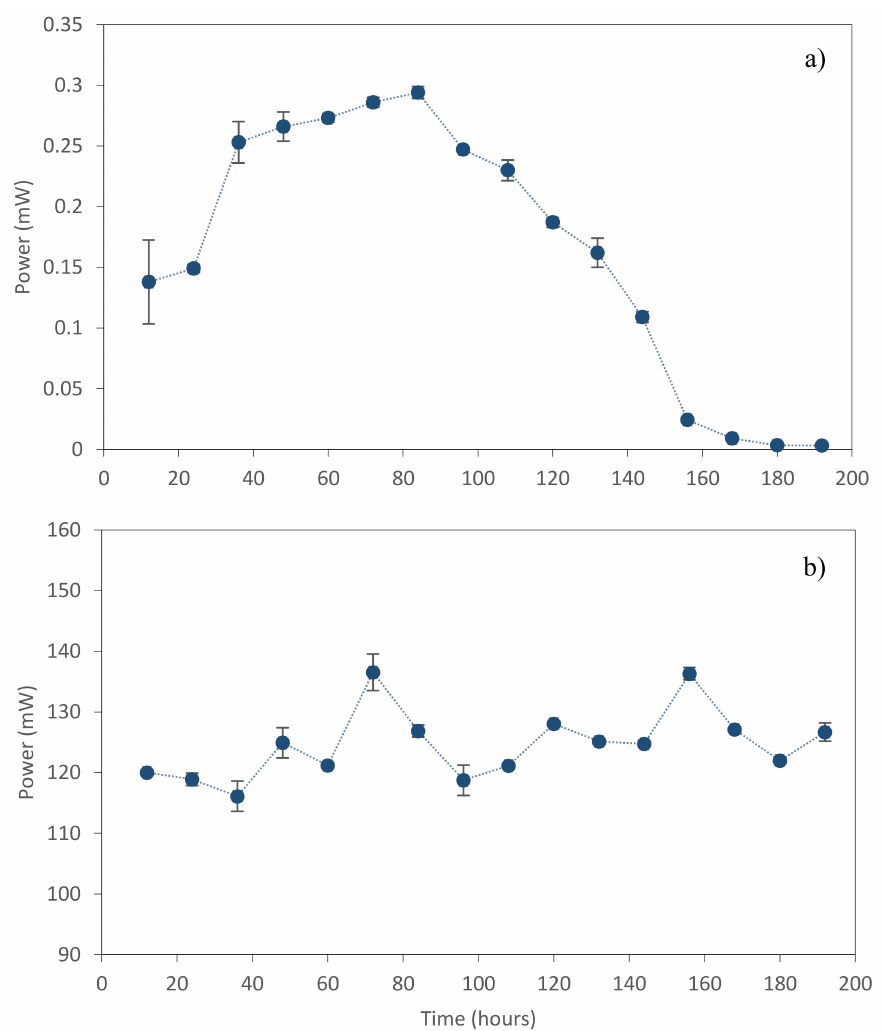
Figure 4. Power over time obtained from ( a ) stacked MFCs connected in parallel with each other (voltage reversal phenomenon), ( b ) energy-harvesting